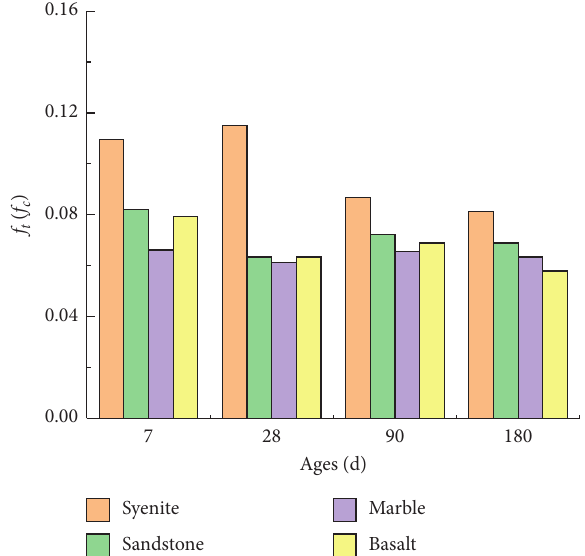
Figure 4: f t / f c of four types of aggregate